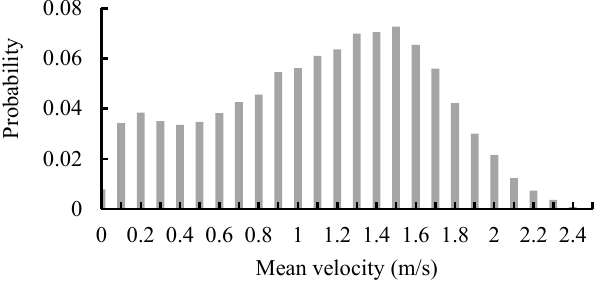
Figure 4. Probability distribution of current velocity at the tidal current turbine (TCT) site.